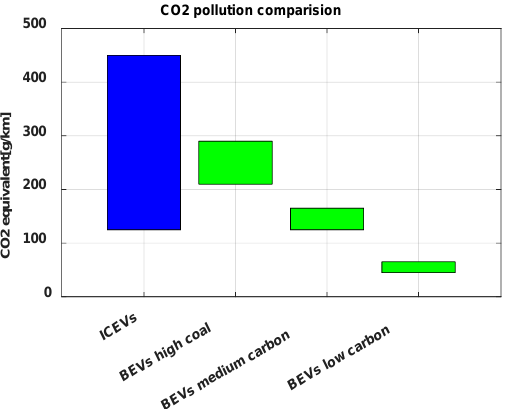
Figure 2. CO 2 pollution comparison between ICE Vehicles (ICEVs) and Battery Electric Vehicles (BEVs) [24].